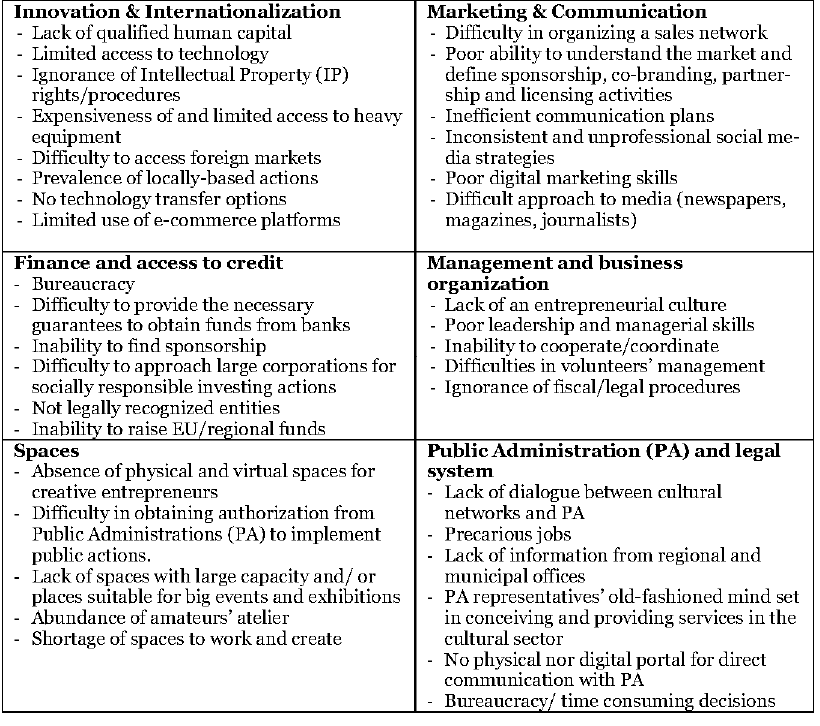
Figure 8. CCIs common challenges to sustainability. Source: TRACES D3.2 and D2.5 deliverables.